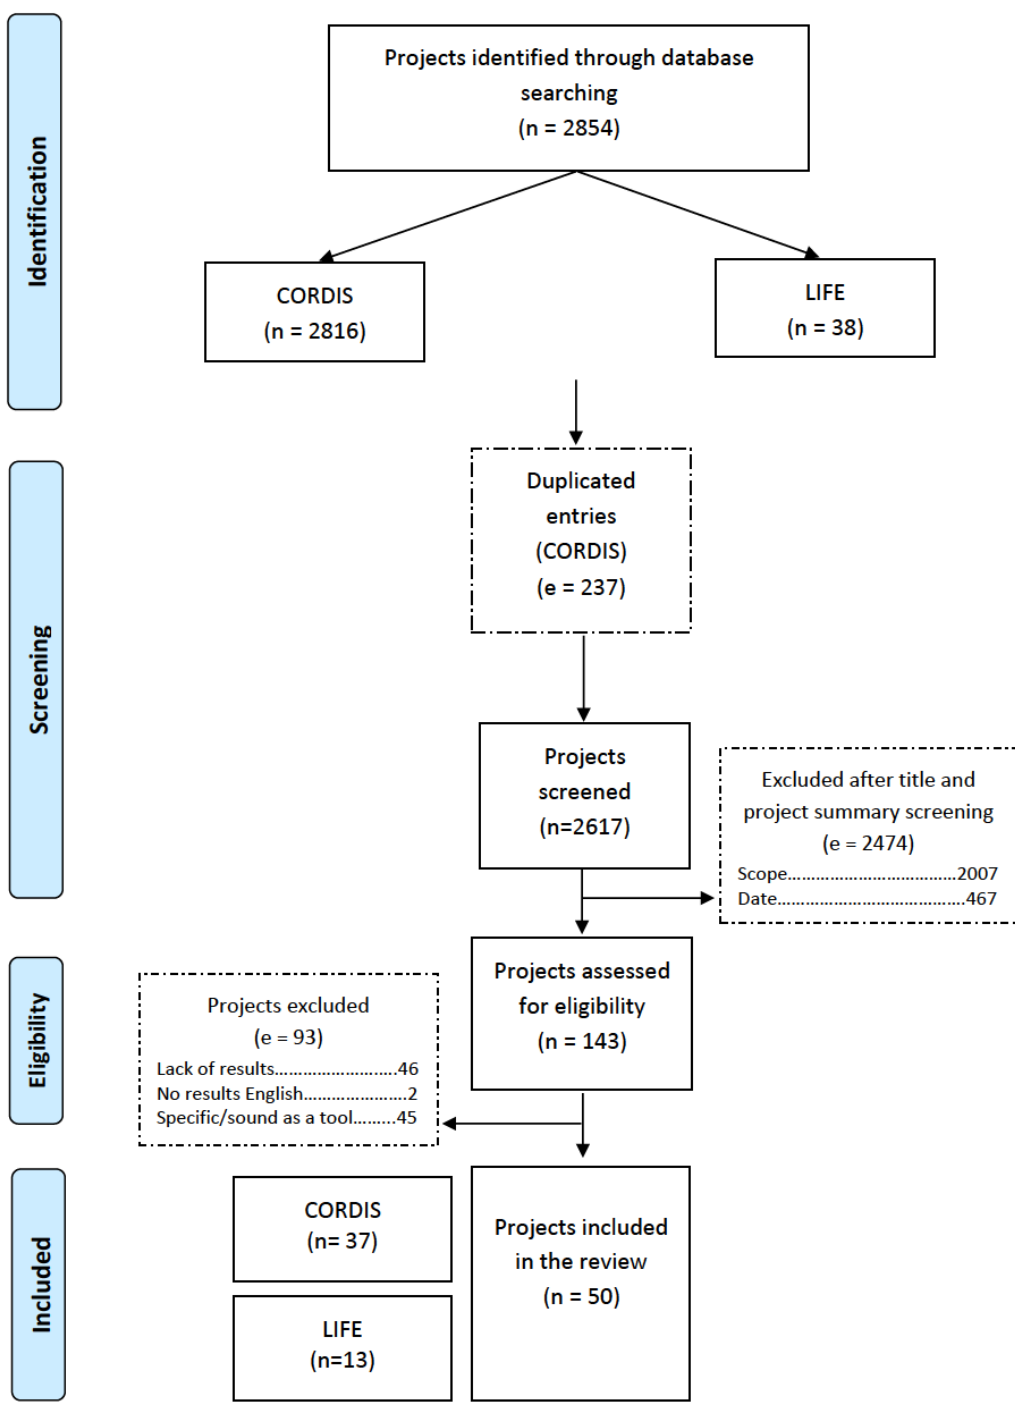
Figure 1: Flow diagram of EU projects’ screening. cluded that sound was used only as a tool to find and track aircrafts. This system could later be integrated with an air- port’s traffic management procedure.